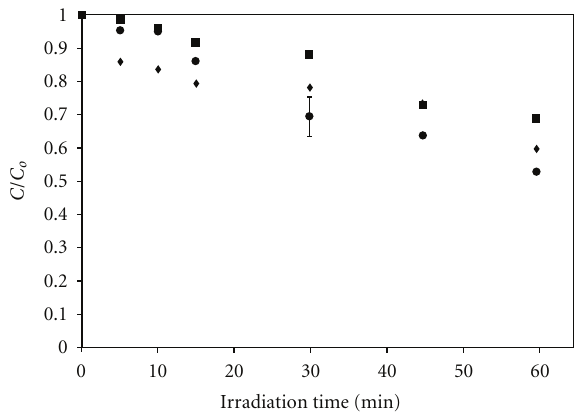
Figure 1: Comparison of the e ffi ciency of degradation of abamectin using di ff erent treatments: — (cid:2) — direct photolysis; — (cid:3) — H 2 O 2 ; — (cid:2) — Fe + UV. Initial conditions: [H 2 O 2 ] = 6.0 mmolL − 1 ; [Fe 3+ ]